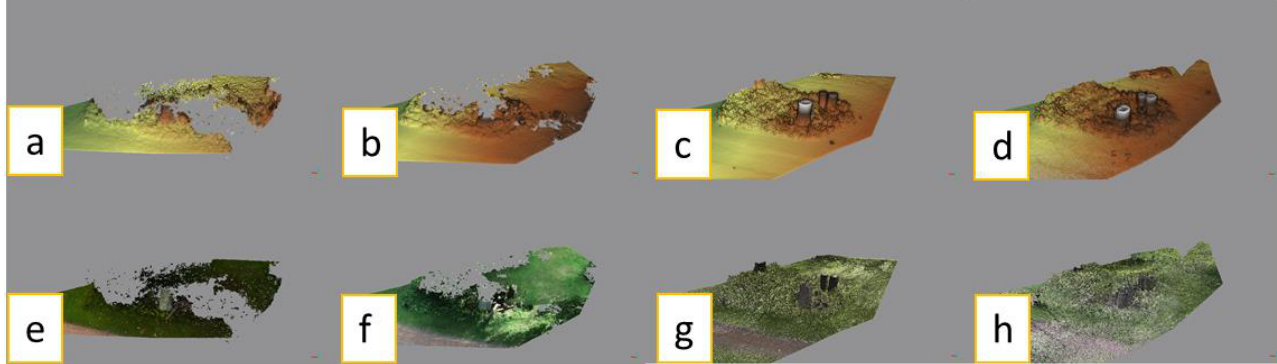
Figure 11. Comparison of point clouds for dead wood/stumps. In the top row, the point clouds are colored with the height ramp, and in the bottom row with RGB colorization.